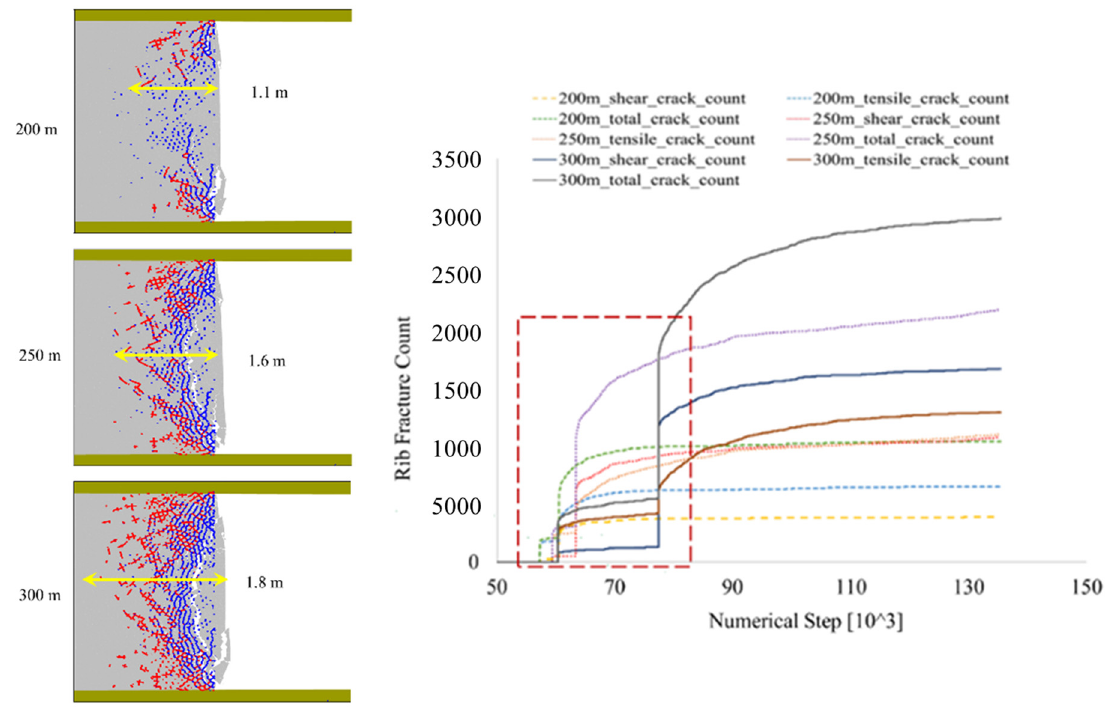
Figure 9. Shear and tensile fracture development in the rib at overburden covers of 200 m, 250 m, and 300 m at coal mass reduction of 1.8.